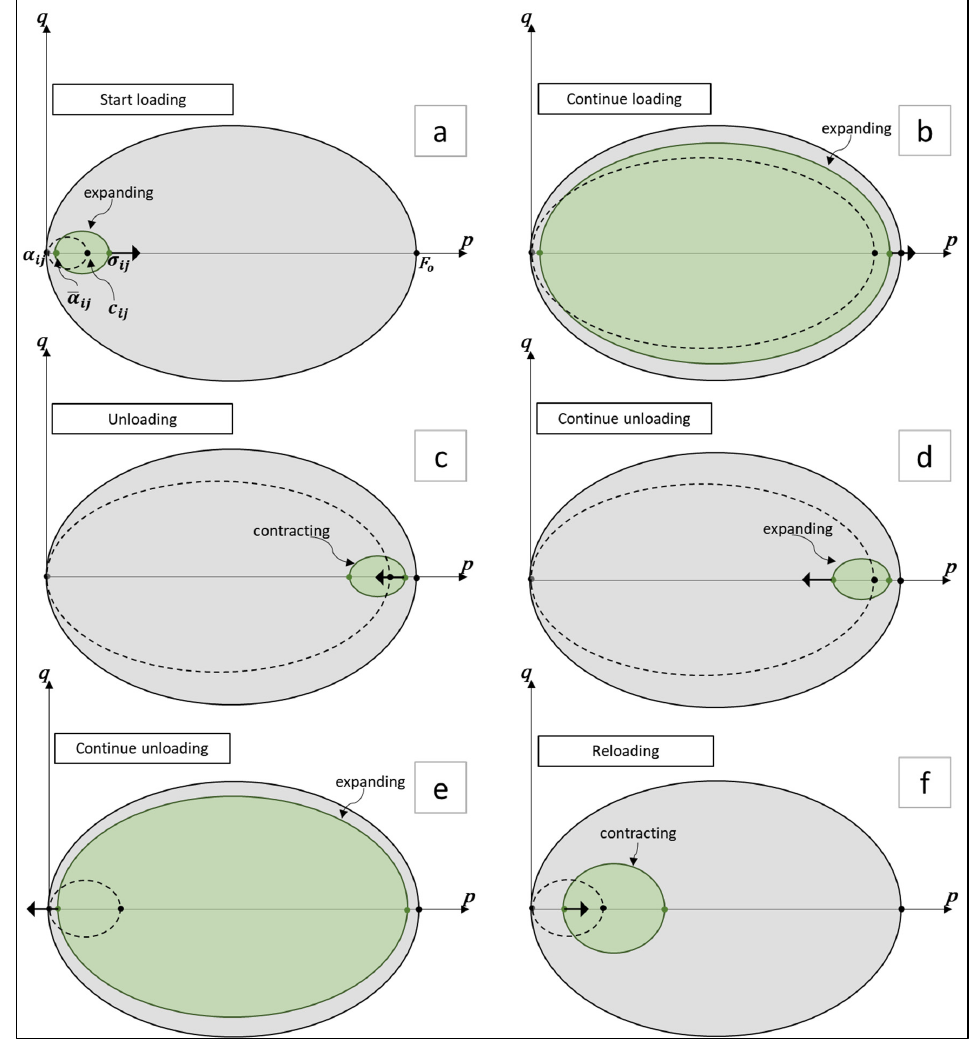
Figure 17. Normal yield, sub-loading yield and elastic core surfaces during stress loading and un- loading.